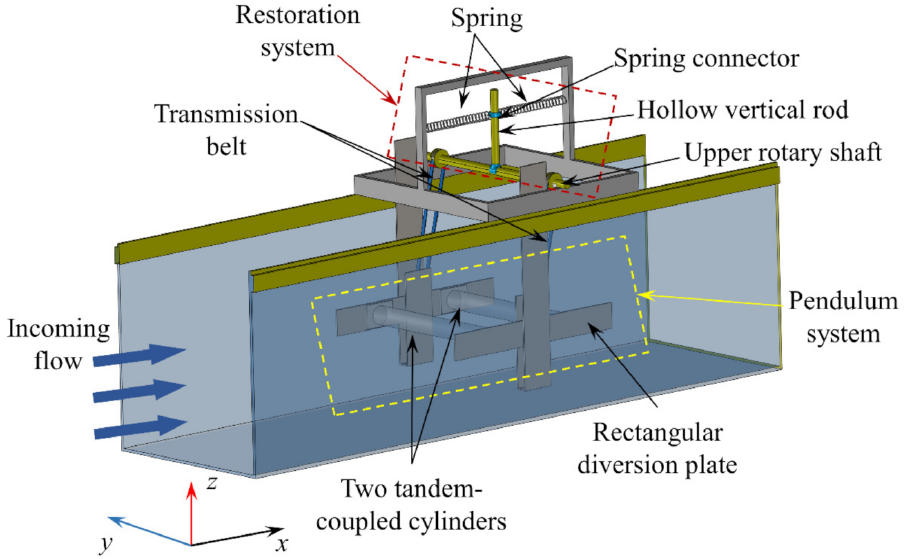
Figure 1. Schematic diagram of the flow-induced